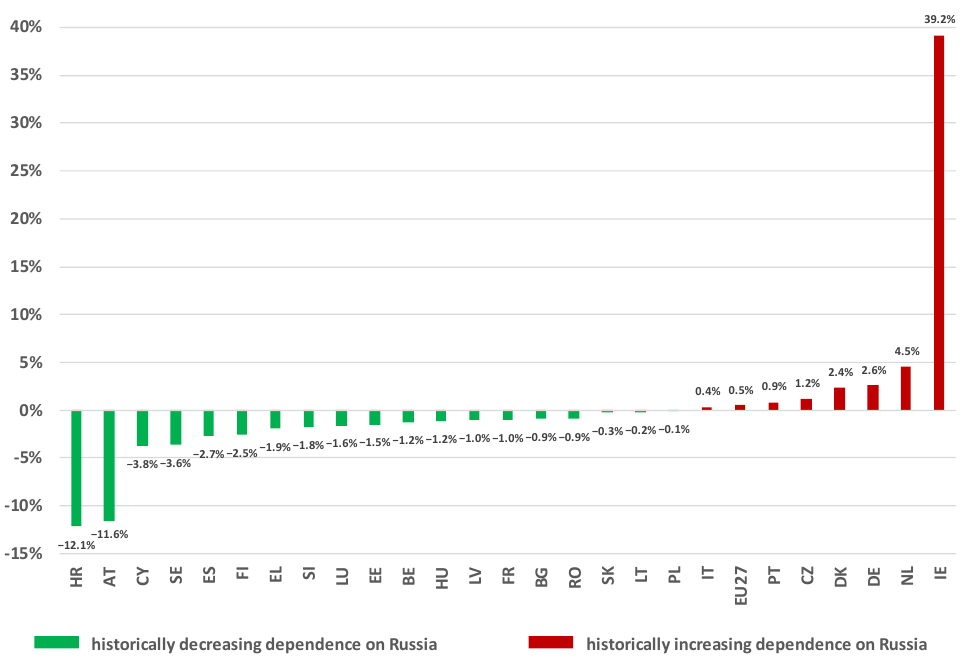
Table 2. Descriptive statistics of DRTs (26 EU member states and the whole EU).